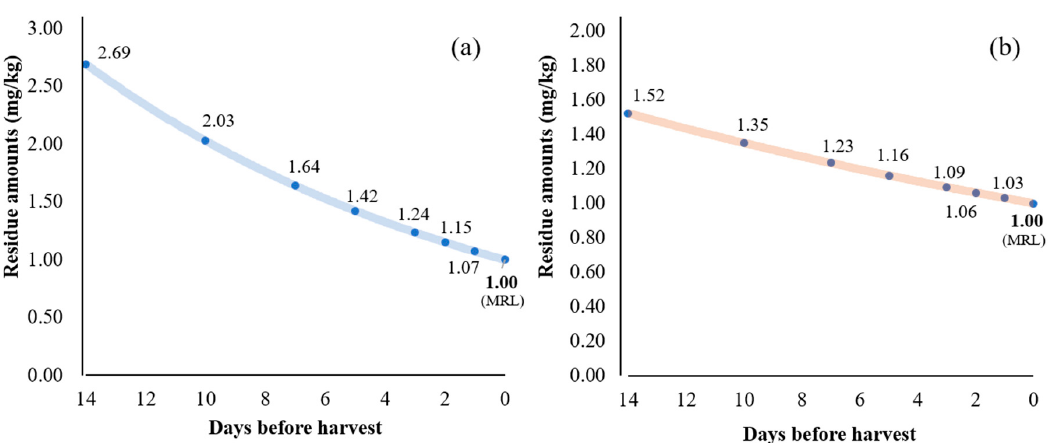
Figure 4. Pre-harvest residue limit curves for acetamiprid ( a ) and chlorantraniliprole ( b ) in kimchi cabbage.